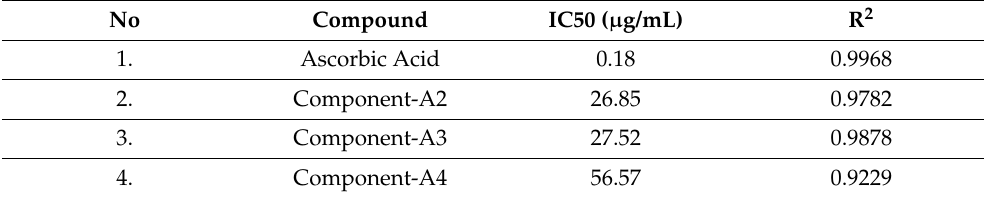
Table 5. UV spectrophotometer observations of the scavenging effect of AA and isolated components A-2, A-3, and A-4 using the ABTS method (average readings of the three tests).